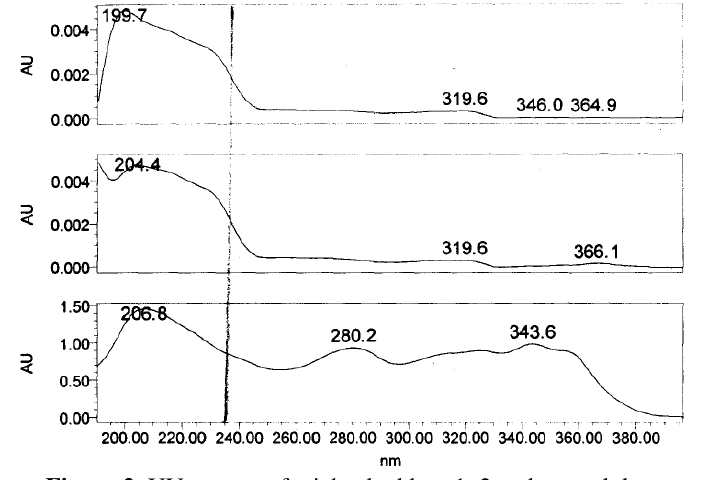
Figure 2. UV spectra of micheal adduct-1, 2 and